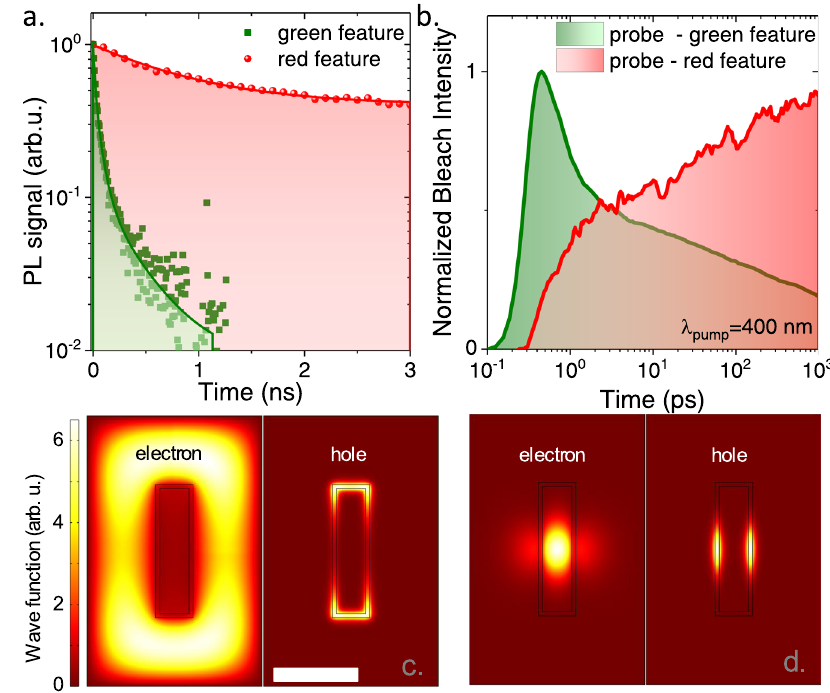
Fig. 2 | Origin of the two-color photoluminescence. a Time-resolved photo- luminescencedecaysassociatedwiththeredandgreenfeatures.Theexperimental data are scattered points, while the solid lines are exponential fi ts. NPL solution is excitedbya407nmpulsedlaserdiode. b Transientabsorptionsignalforthegreen